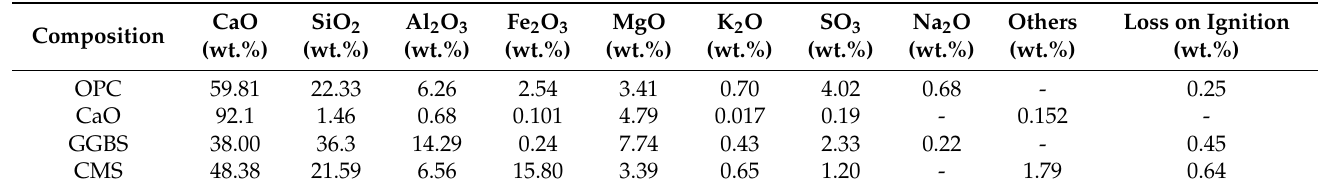
Table 2. Chemical compositions of